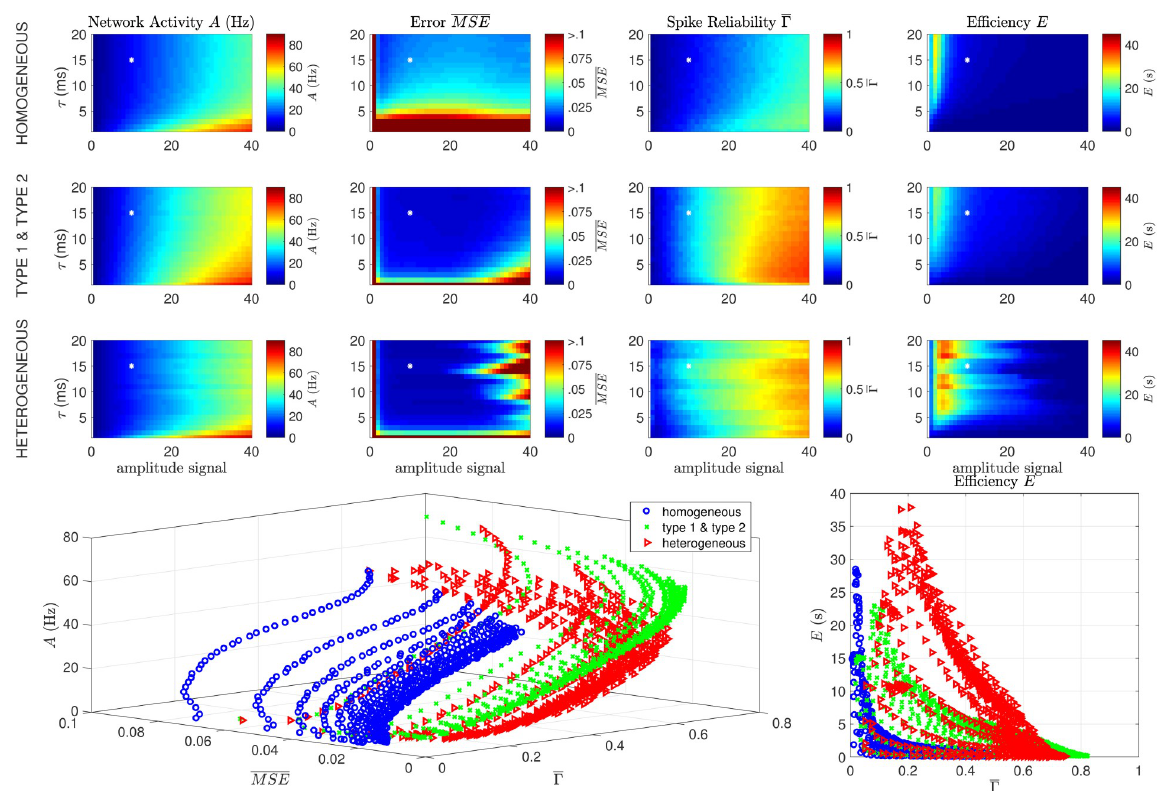
Fig 4. eterogeneous networks are more efficient and show less trial-to-trial variability. Results of two simulations using the same stimulus, but different initial network states, in a homogeneous ‘type 1’ network (first row), a network with ‘type 1’ and ‘type 2’ neurons (second row) and a heterogeneous network (third row). Each data point was simulated ten times and averaged. The network network activity A (first column), spike reliability � G (second column), network MSE (third column) and efficiency E (fourth column) are shown as a function of the time constant ( τ ) and amplitude of the stimulus. All networks perform well over a wide range of stimulus amplitudes and frequencies, but the heterogeneous network is more efficient for a wider range of input parameters, in particular for fast-fluctuating low amplitue signals. The bottom row shows the same data presented differently: every data point is the average over 10 trials of a single value of the input stimulus amplitude and τ . This shows how the network activity, error and efficiency depend on the spike reliability � G . Parameters: Δ = 7, 5 ms, ν = μ = 1, 5, N = 100, trials = 10. The white star denotes the parameter values used in section Heterogeneous networks are more efficient than homogeneous networks.